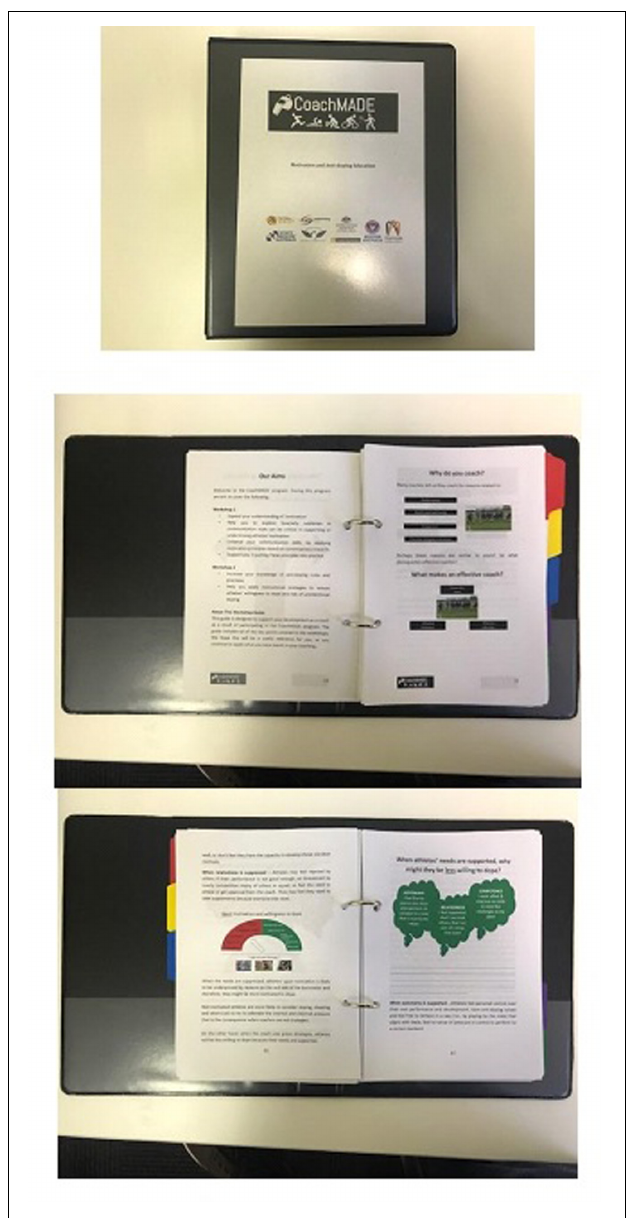
FIGURE 2 | Workbook